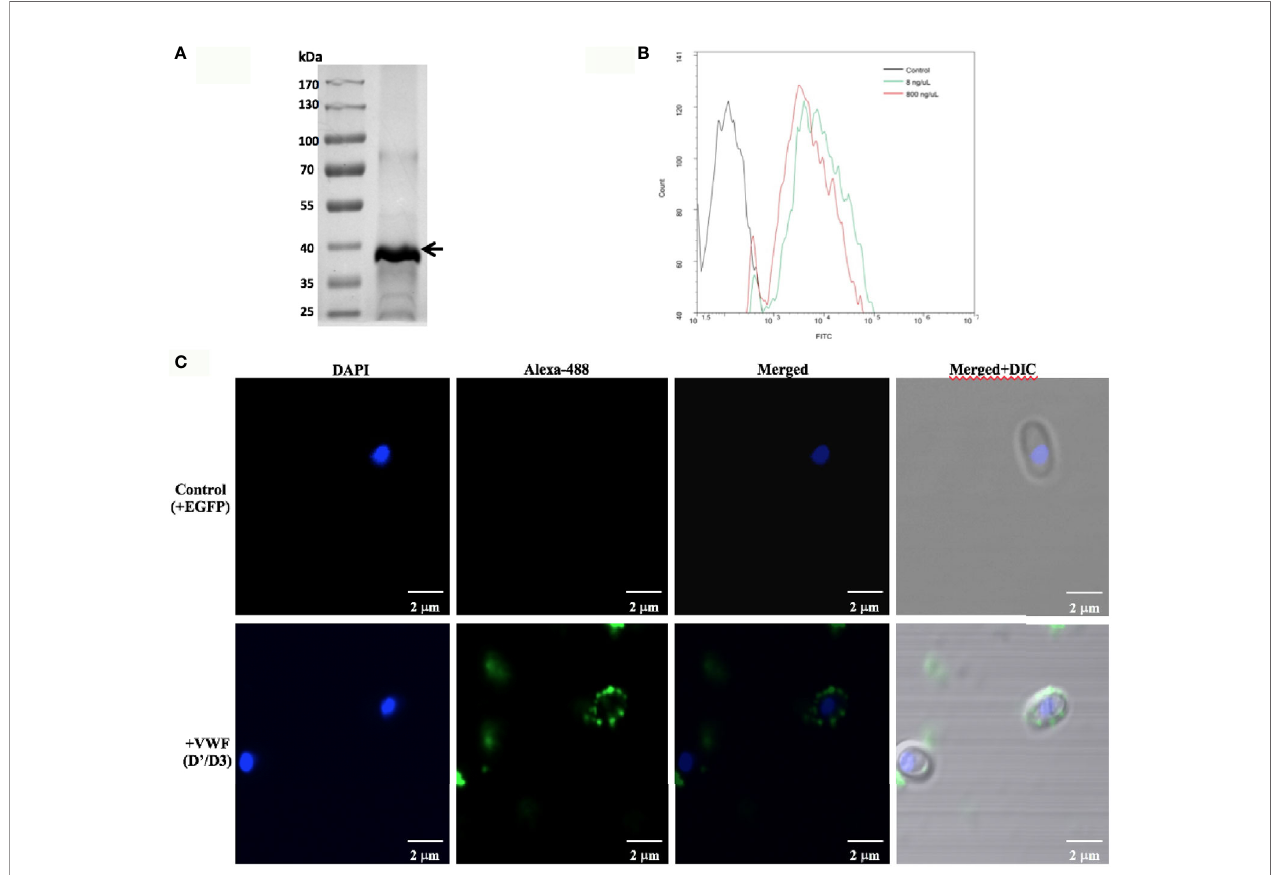
FIGURE 2 | VWF-D ’ D3 binds to E. hellem spores . (A) Coomassie staining of recombinant VWF-D ’ D3. Arrow shows the major protein size at the expected size ~40 kDa. (B) Flow cytometry analysis of D ’ D3 binding to E. hellem . E. hellem spores (1 × 104 cells) were incubated respectively with, isotype antibody control (in black line), 8 ng/µl recombinant VWF-D ’ D3 (in green line), and 800 ng/µl recombinant VWF-D ’ D3 (in red line). The result showed that with the increasing amount of recombinant VWF adding, the fl uorescence signal increased as well. (C) Representative images of E. hellem spores were incubated with either control, recombinant EGFP (top) or VWF-D ’ D3 (bottom), both at 20 µg/ml for 30 min, then the spores were washed by PBS. After fi xation, the direct interaction between VWF (green) and E. hellem (blue) was observed by fl uorescent microscope (Scale bar = 2